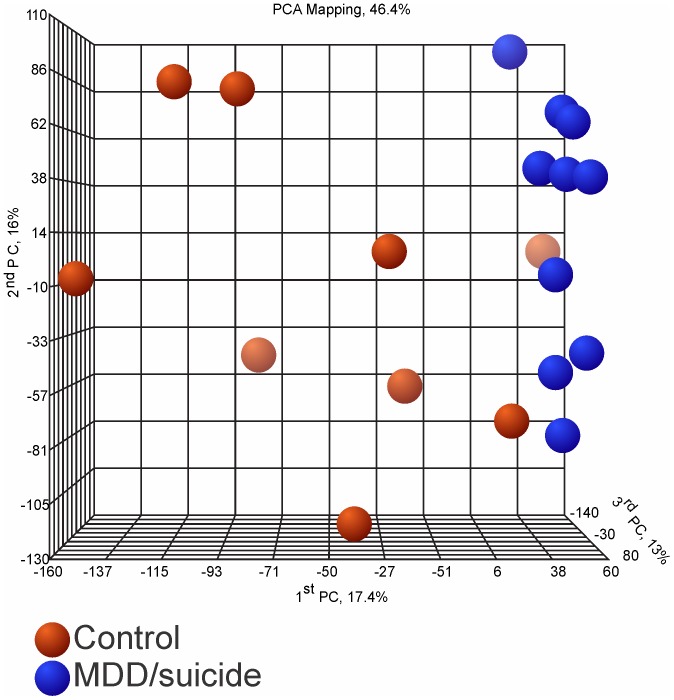
PCA demonstrates separation of control and depressed suicide subject groups. PCAof microarray expression data based on complete data set. Red nodes represent control subjects, blue nodes - depressed suicide victims. Variable shading indicates distance from a viewer in 3D space.